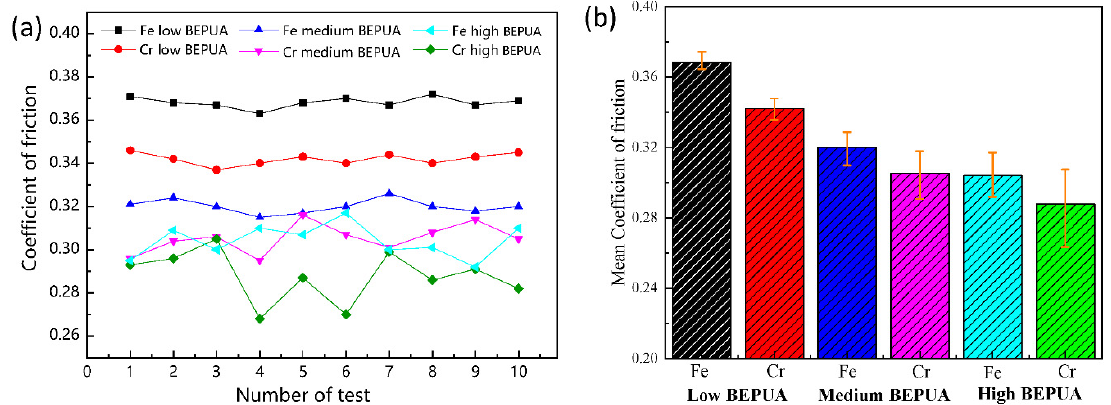
Figure 16. Variations in the coefficient of friction with the number of tests ( a ) and the mean coefficient of friction ( b ) of Cu–BCs containing Fe and Cr.